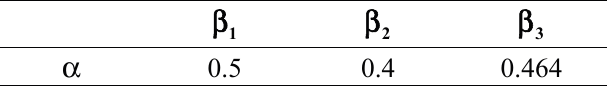
Table 2. The weight of the parameters.